Question: Write a descriptive caption for this figure.
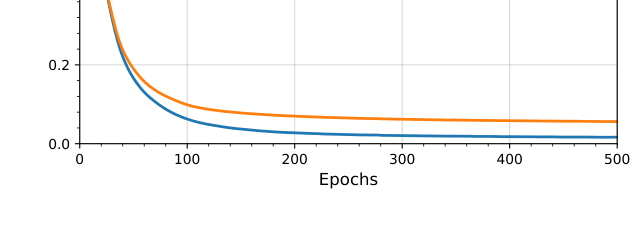
Answer: Training and testing NRMSE (loss) over the epochs of the gradient descent algorithm.